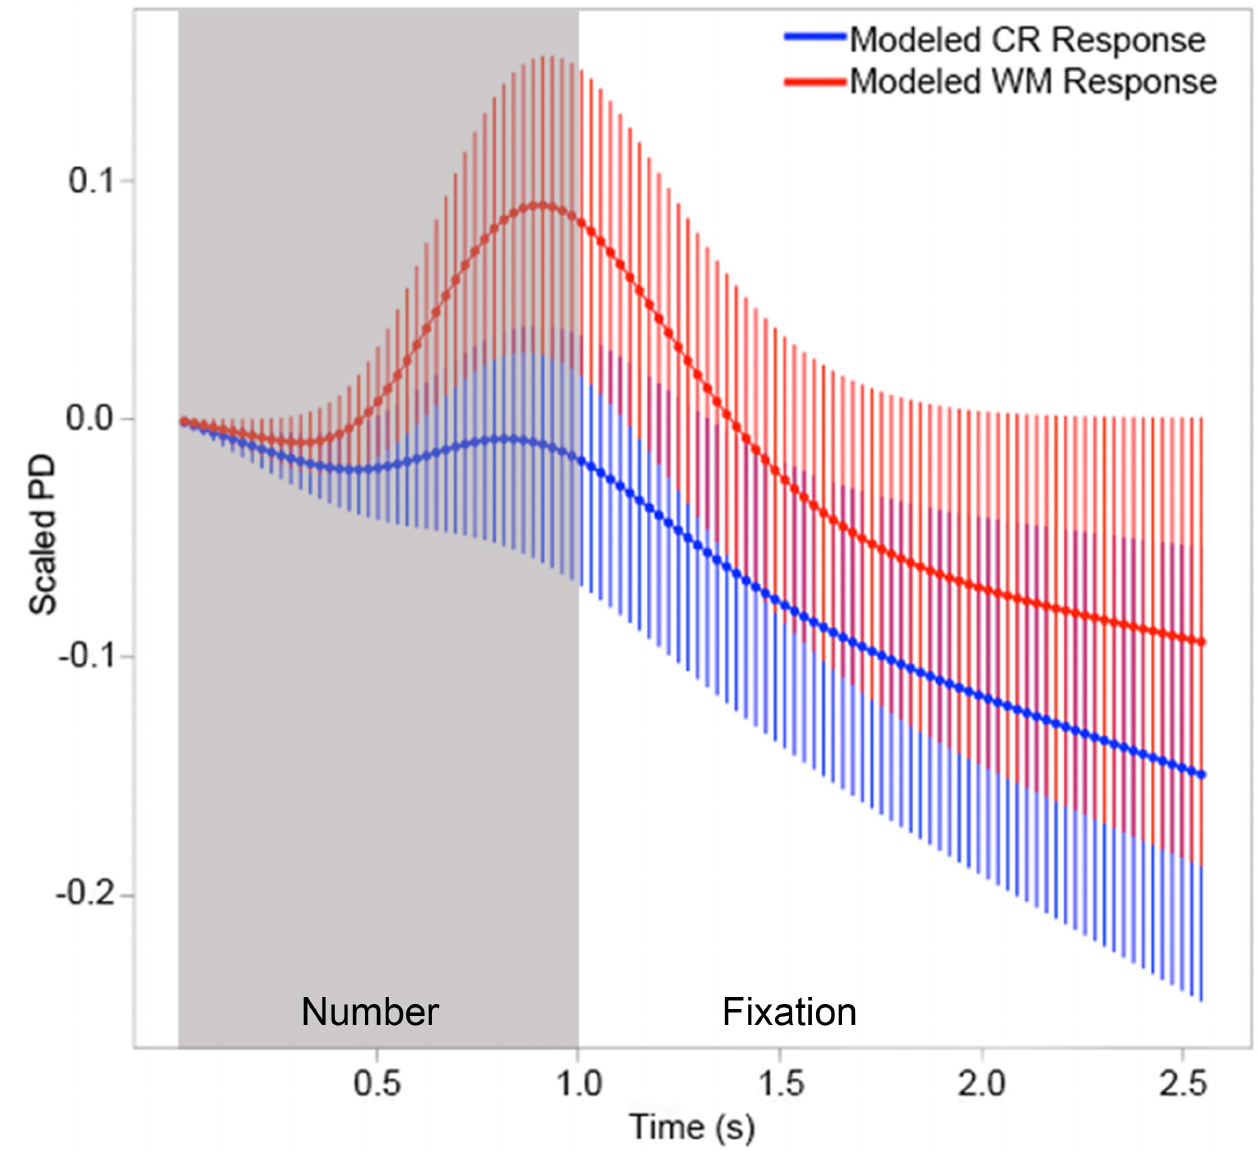
Figure 4. Attentional pulse strengths of non-probe stimuli differ as a function of attention. Wierda and colleagues’ automated pupil dilation deconvolution algorithm [36] was used to derive the attentional pulse strengths associated with non-probe stimuli in WM and CR conditions. This attentional pulse was significantly stronger in the WM condition ( M1 =.254, SD1 =.28) than in the CR condition ( M2 =.064, SD2 =.11), t (15)=2.333, p =.03. The deconvolved pupillary responses to non-probes are displayed above, with error bars indicating one standard error of the mean.